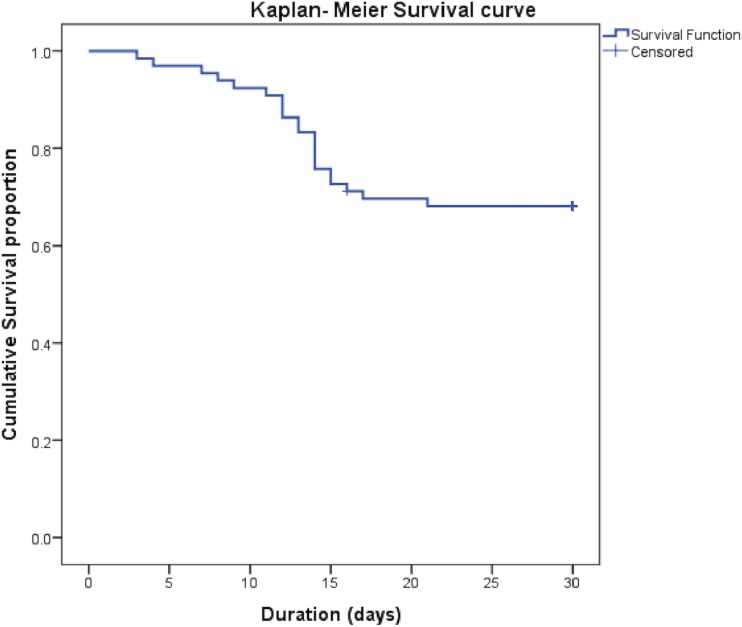
Kaplan Meier survival curve at 30 days of patients given granulocyte transfusions (GTX).